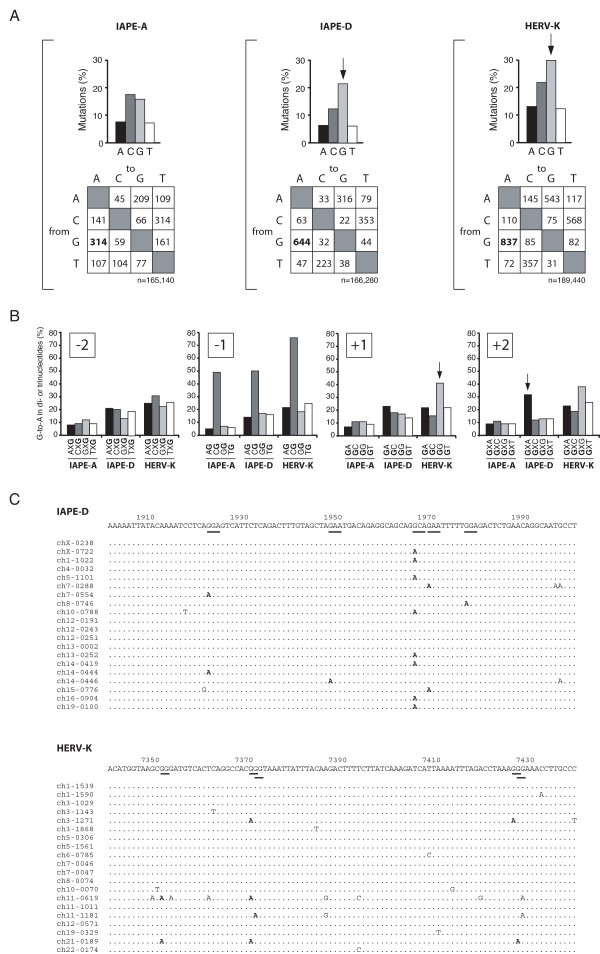
Distribution of the nucleotide substitutions in the IAPE-D and HERV-K genomic copies residing in the mouse and human genomes. Endogenous sequences were extracted from the mouse and the human genome databases, aligned and compared to the derived consensus. (A) Upper panels: percentage of substitutions for each nucleotide, for the endogenous IAPE-D and HERV-K elements (with the IAPE-A elements used as a control). Lower panels: two-entry tables showing nucleotide substitutions preferences, with the G-to-A values in bold (higher that the "non-specific" C-to-T value for IAPE-D and HERV-K, and identical in the case of the IAPE-A control). n, total number of nucleotides analyzed. (B) Influence of nucleotides at position -2, -1, +1 and +2 on G-to-A mutations (the mutated G is at position 0). Data represent the percentage of indicated target di- or trinucleotide sequences bearing G-to-A mutations. X represents any nucleotide. P-values calculated for the two-entry tables (in A) by a Poisson regression in a log-linear model for the occurrence of the G-to-A versus C-to-T mutations yielded p < 0.003 for IAPE-D and HERV-K; in B, p-values calculated by a chi square test were p < 0.001; similar levels of significance were obtained using the Kruskal Wallis test. (C) Example of G-to-A mutations present in twenty IAPE-D (upper panel) and HERV-K (lower panel) sequences. GXA trinucleotides and GG dinucleotides are underlined in the consensus sequence of IAPE-D and HERV-K, respectively.